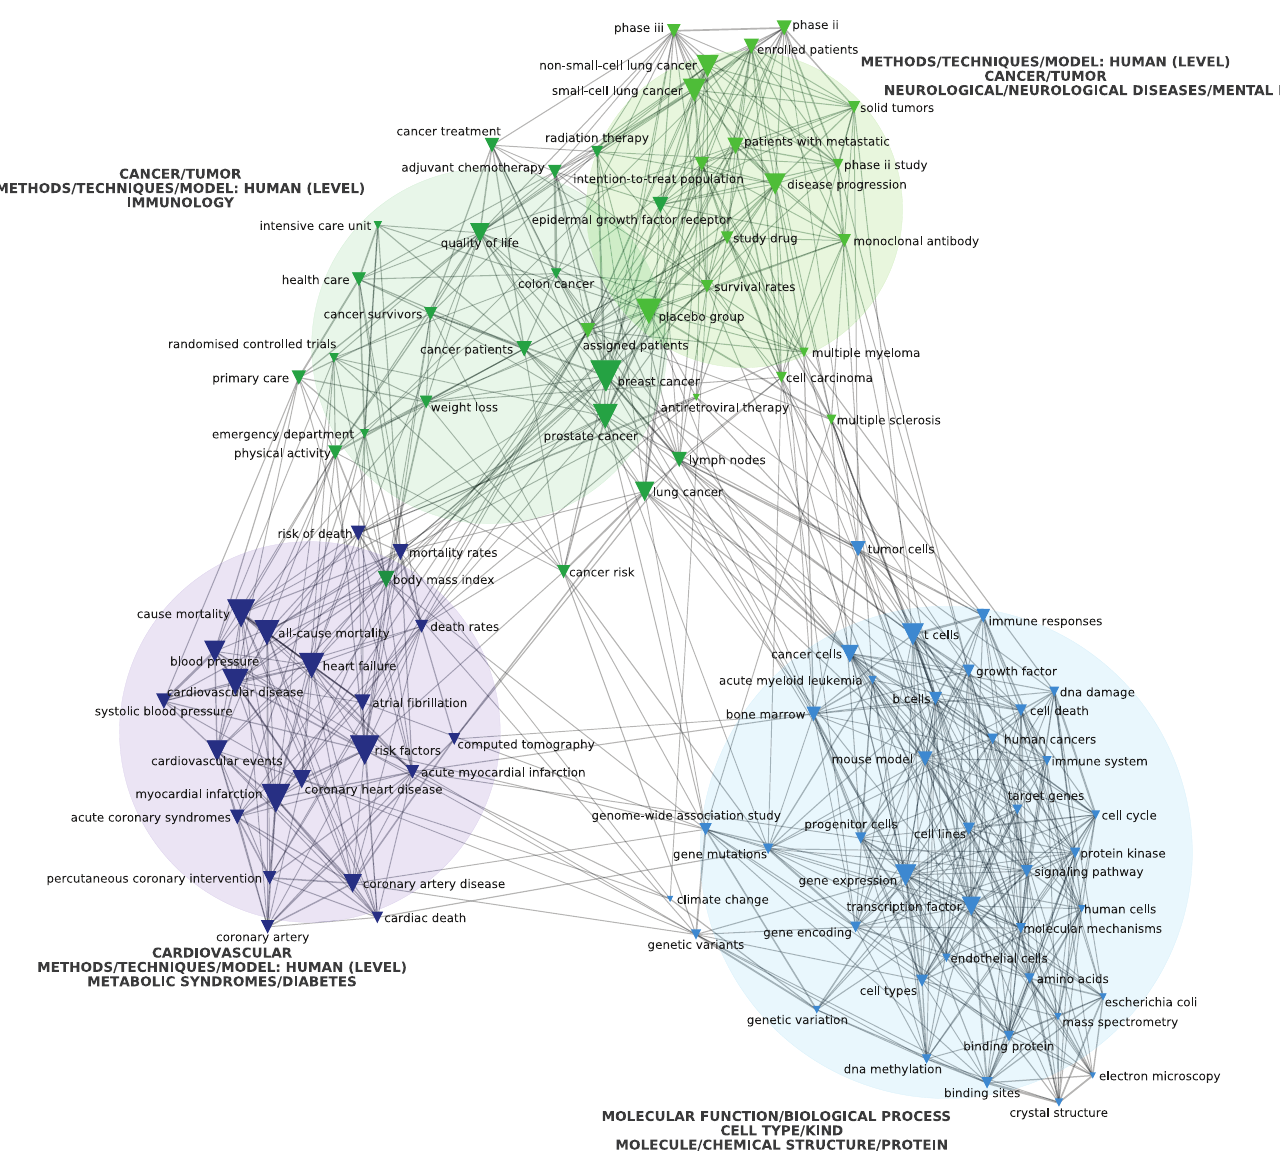
Fig 4. Top 100 HBMS research multi-terms (2009 to 2018) plotted according to co-occurrence using a chi-squared distribution. Source: Authors’ analysis based on WoS data extraction plotted via CorTexT.